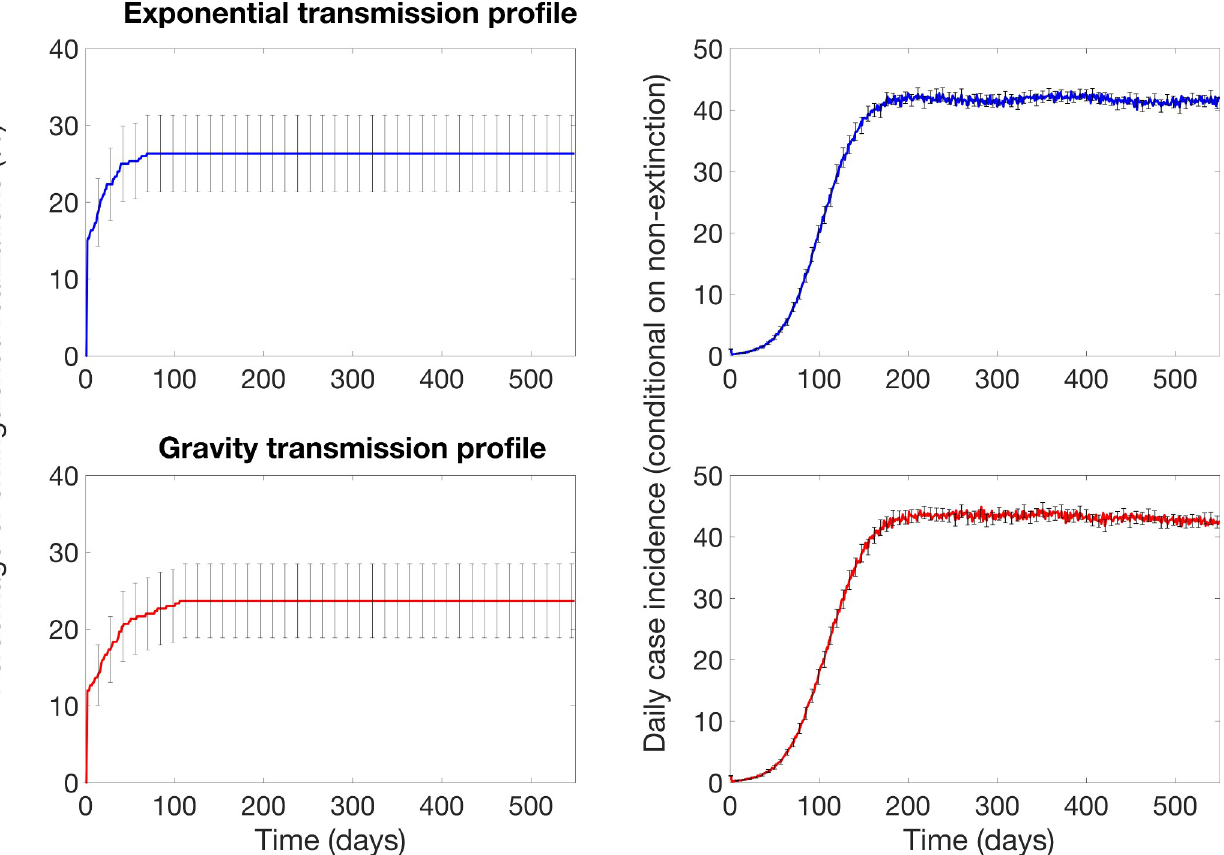
Fig 4. Probability of epidemic extinction and the baseline mean daily incidence curves in the absence of interventions for the exponential and gravity transmission profiles that define transmission rates as a function of the distance from an infectious individual (see also Fig 3). For each transmission profile, the model was calibrated by choosing the community size for each transmission profile by assuming that the ongoing Ebola outbreak in North Kivu would be similar in size to the 2014–16 Ebola outbreak in Liberia in the absence of vaccination. Outbreaks propagate through the population as spatial waves with an endemic state. The average number of cases for the n th day is averaged only for the number of simulations that have not yet extinguished by day n. The error bars show the 95% confidence intervals for the mean daily